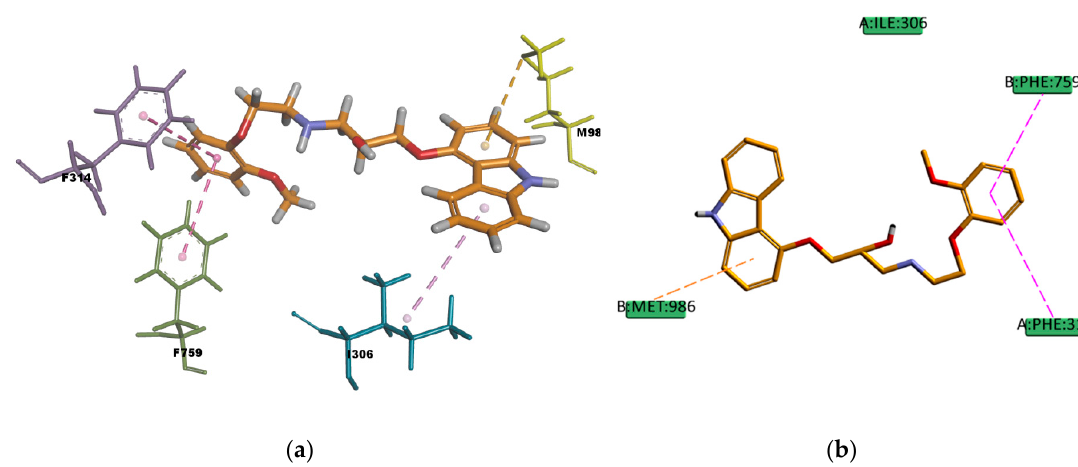
Figure 17. Carvedilol (CAR) top-ranked pose obtained with CDOCKER algorithm. ( a ) 3D view of CAR interactions in the binding pocket. The light-rose dotted lines represent hydrophobic interactions, pink dotted lines represent π – π T-shaped interactions, and the orange dotted line represents a π –sulphur interaction. Residue M986 involved in π –sulphur interaction is highlighted in yellow; ( b ) 2D interaction diagram of CAR with h P-gp interacting residues. The pink dotted lines represent π – π T-shaped interactions, and the orange dotted line represents the π –sulphur interaction with the residue M986.